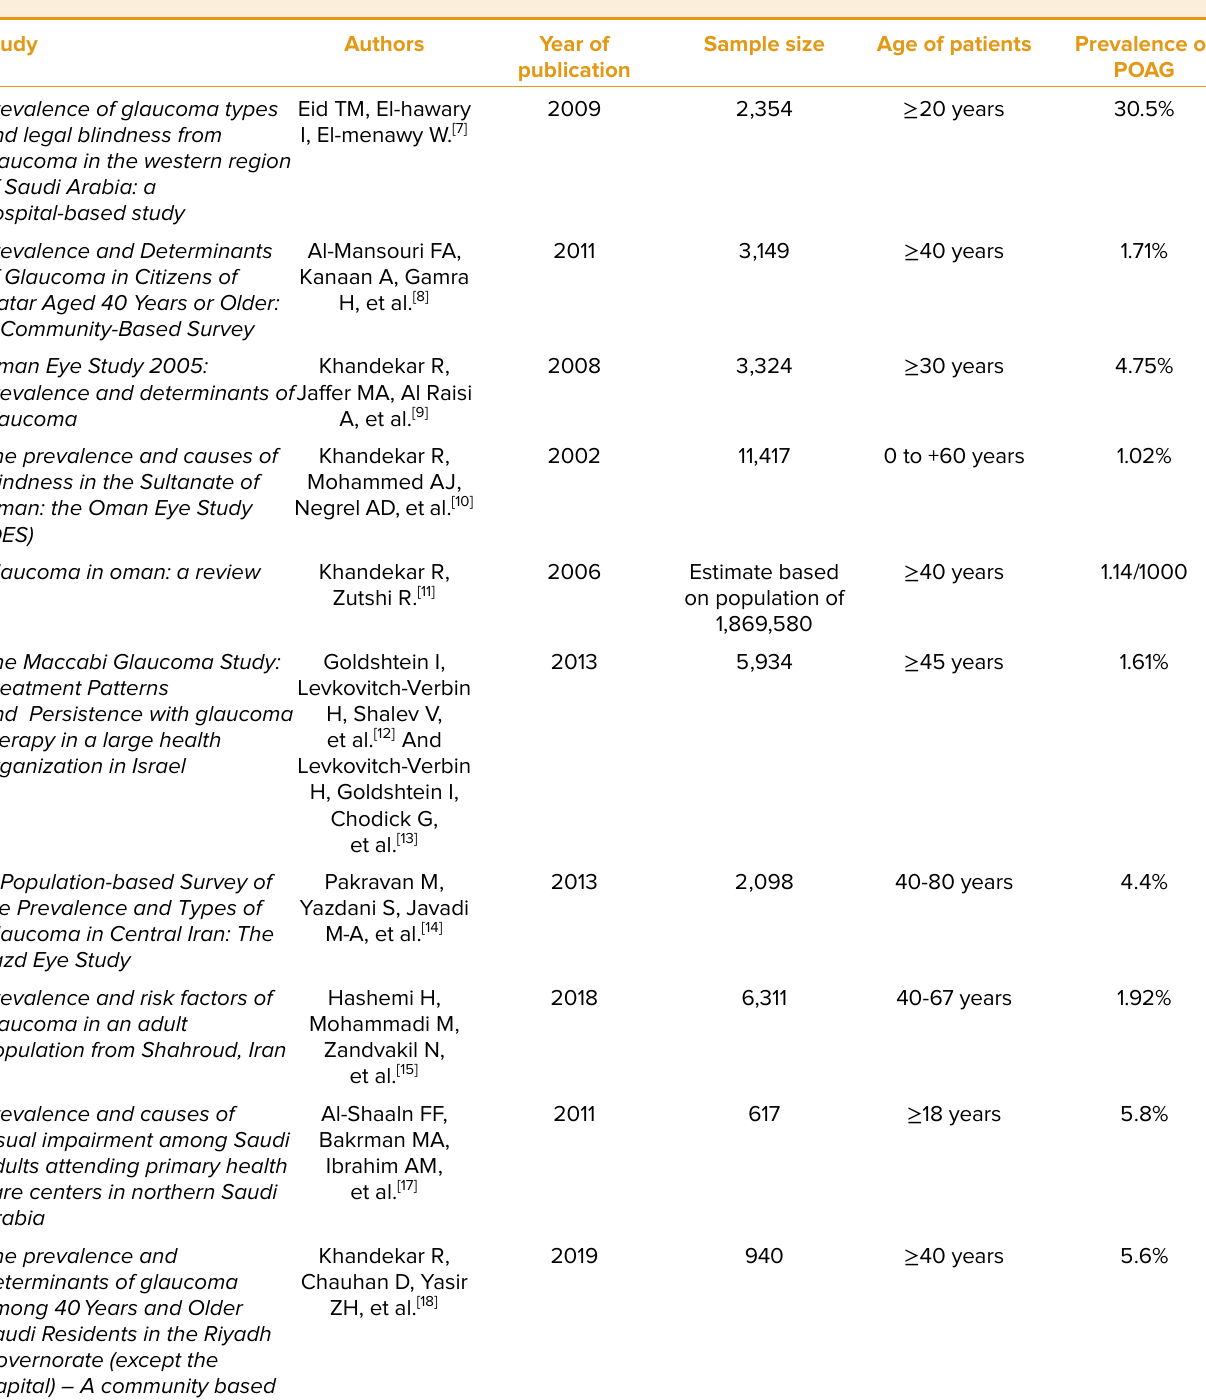
Table 2. Summary of articles relating to primary open-angle glaucoma prevalence in Middle Eastern